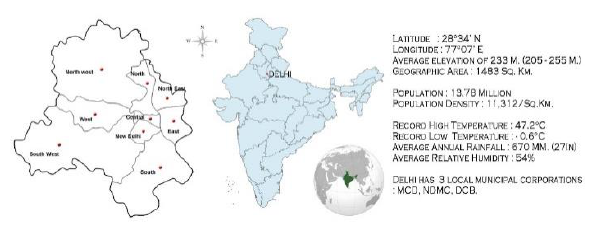
Figure 2 . Location of